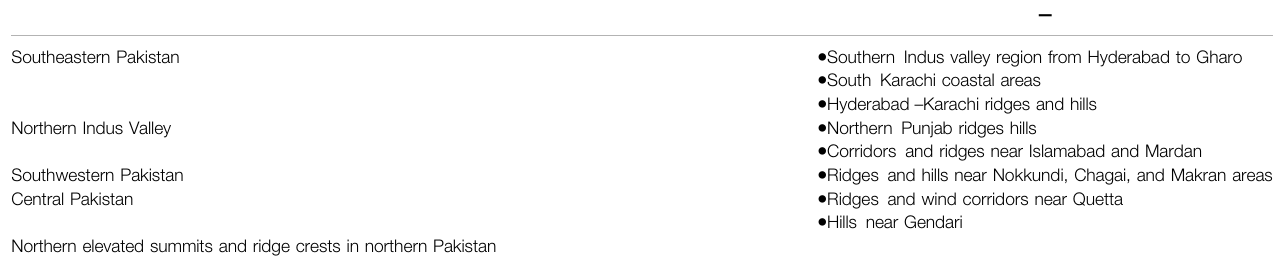
TABLE 2 | Potential sites for wind power generation in Pakistan (Shami et al.,